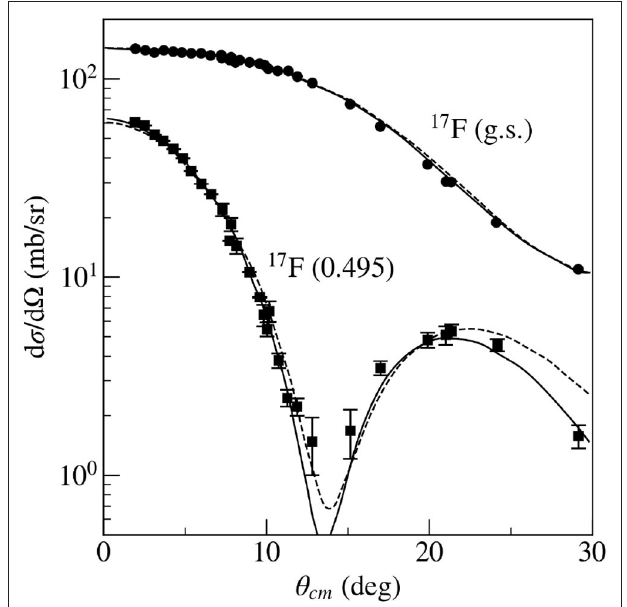
FIGURE 5 | The experimental S-factors and S-factors determined from the ANCs of the 16 O( 3 He,d) 17 F reaction (Gagliardi et al., 1999). The solid data points are from Morlock et al. (1997), and the open boxes are from Chow et al. (1975) . The solid lines indicate the calculated S-factors, and the dashed lines correspond to the ± 1 σ error